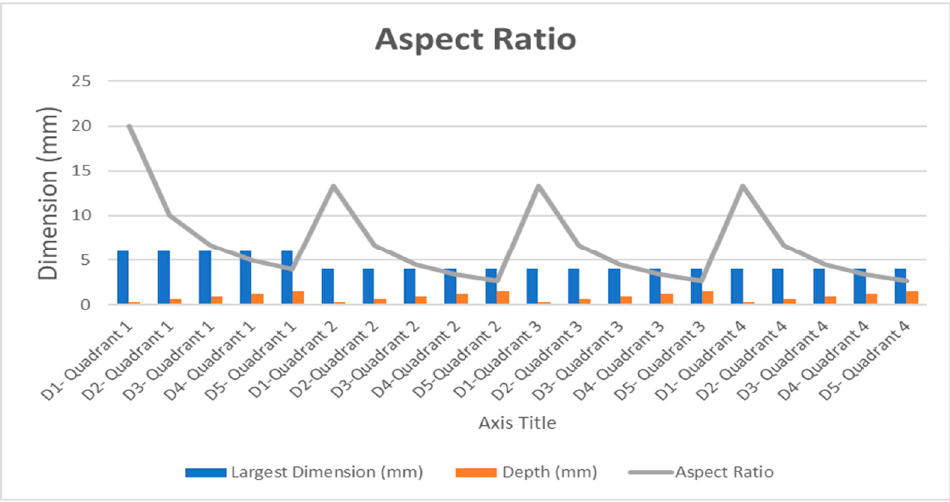
Figure 9. Aspect Ratio Calculations for one cylindrical sample.